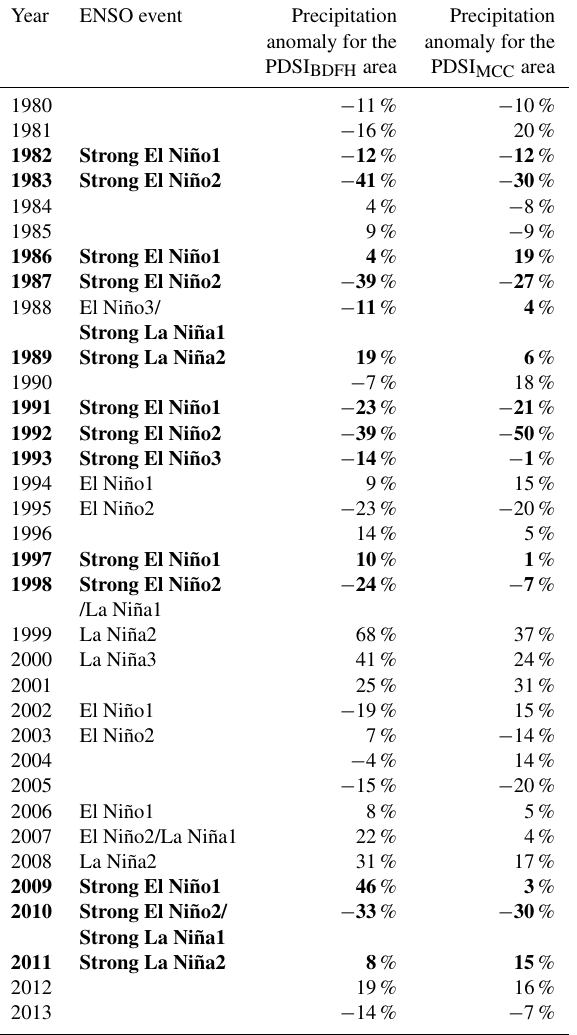
Table 3. ENSO events (NOAA, 2015) and March–May precipita- tion anomalies in the areas of PDSI BDFH and PDSI MCC over the period of 1980–2013. Locations of PDSI areas are shown in Fig. 2. Strong ENSO events (as in NOAA, 2015) are highlighted in